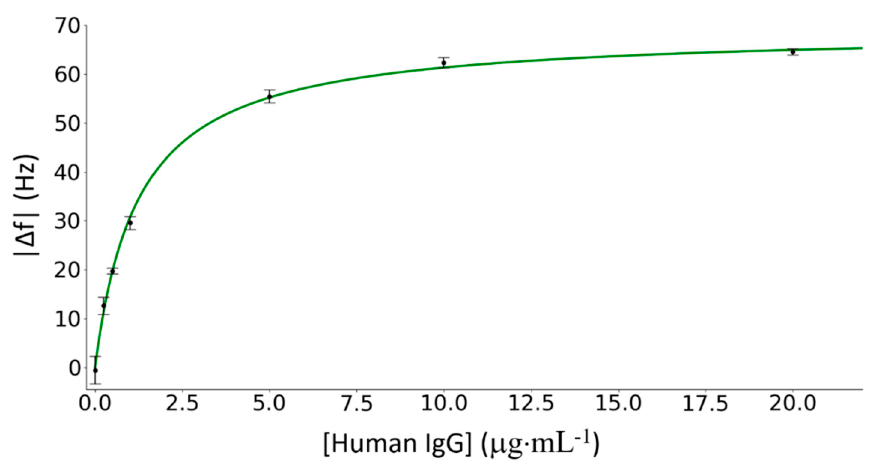
Figure 6. Dose–response curve, i.e., resonance frequency shifts 𝛥𝑓 versus human IGg concentrations. Experimental data are fitted by Langmuir isotherm curve (Equation (5)). The range of tested concentrations varies from the zero concentration to 20 μ g ∙ mL − 1 . Each concentration has been tested using different ribbons.